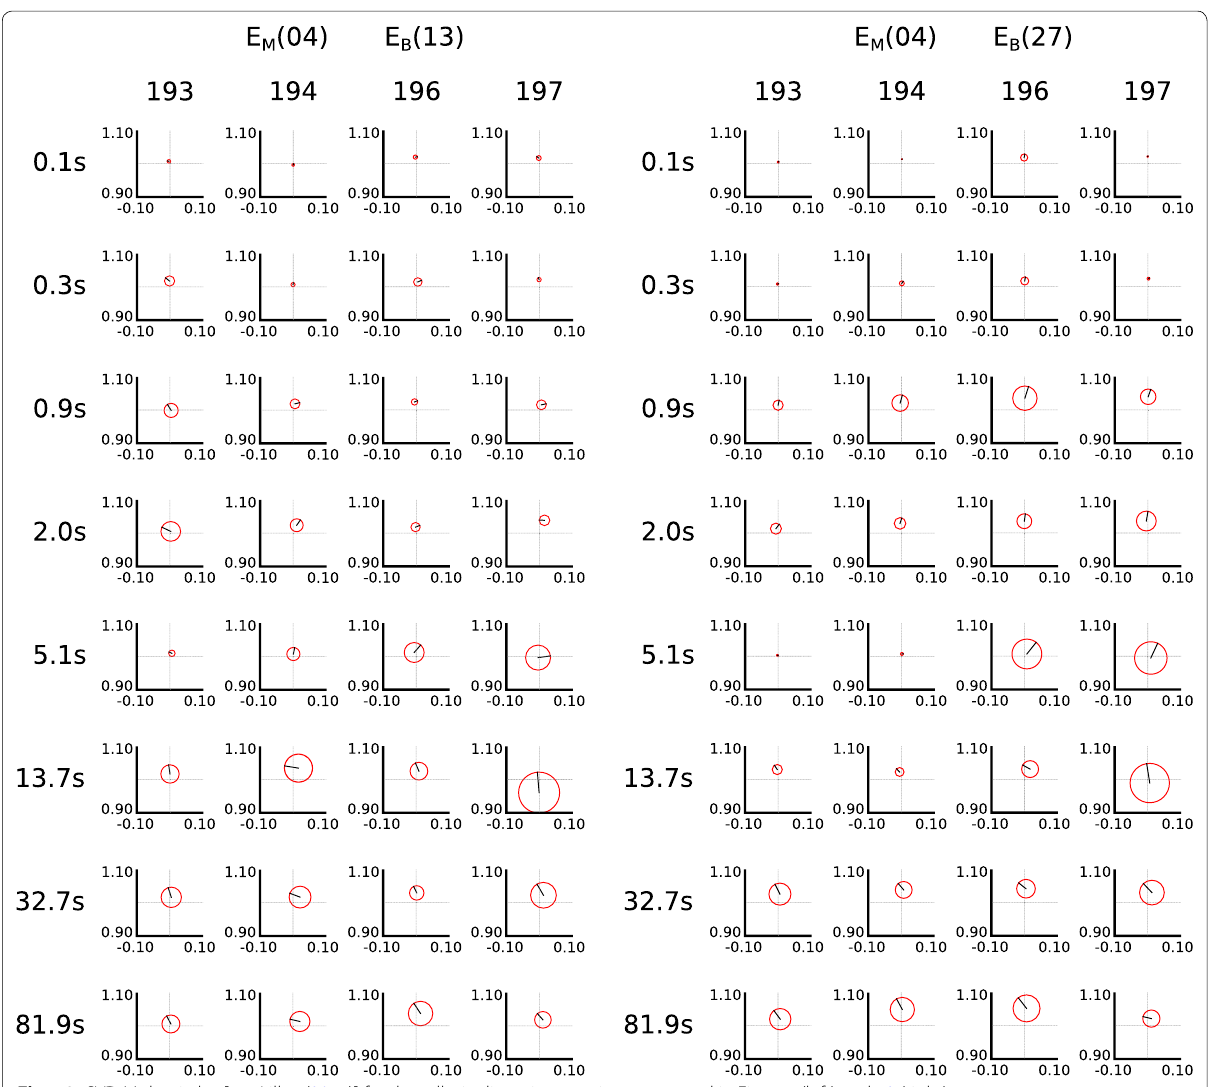
Fig. 13 SVD Mohr circles [see Lilley (2015)] for the telluric distortion matrices presented in Figs. 11 (left) and 12